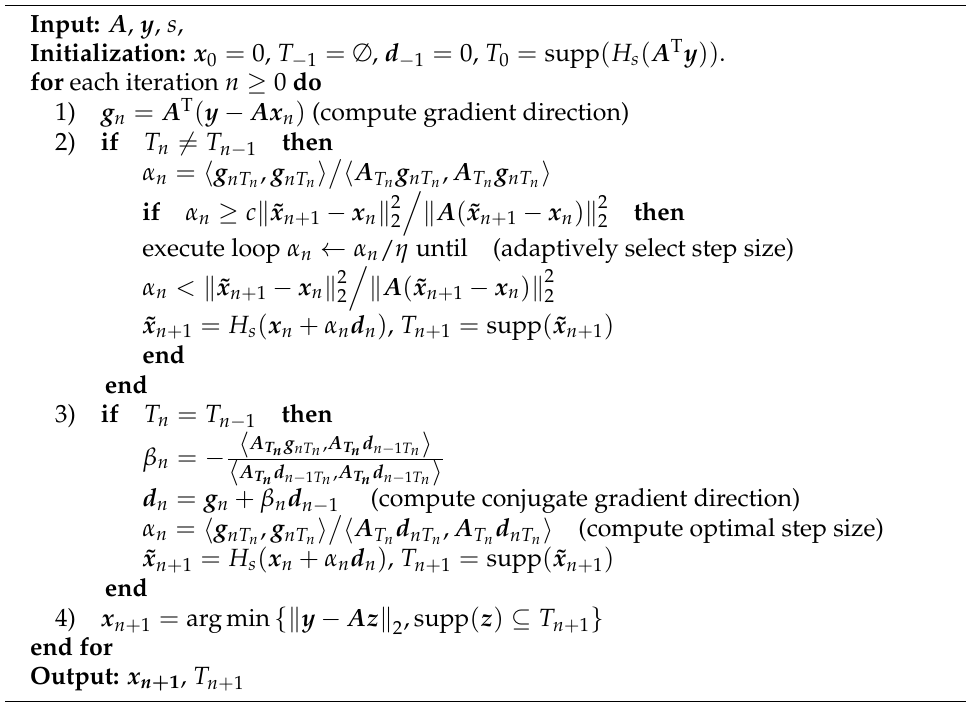
Algorithm 3 Conjugate Gradient Hard Thresholding